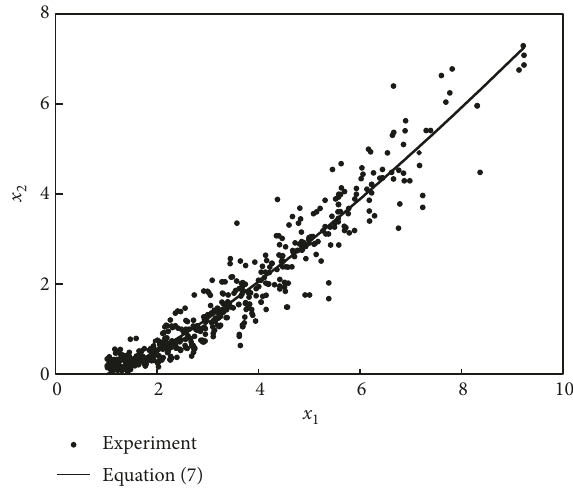
Figure 4: Relationship between x